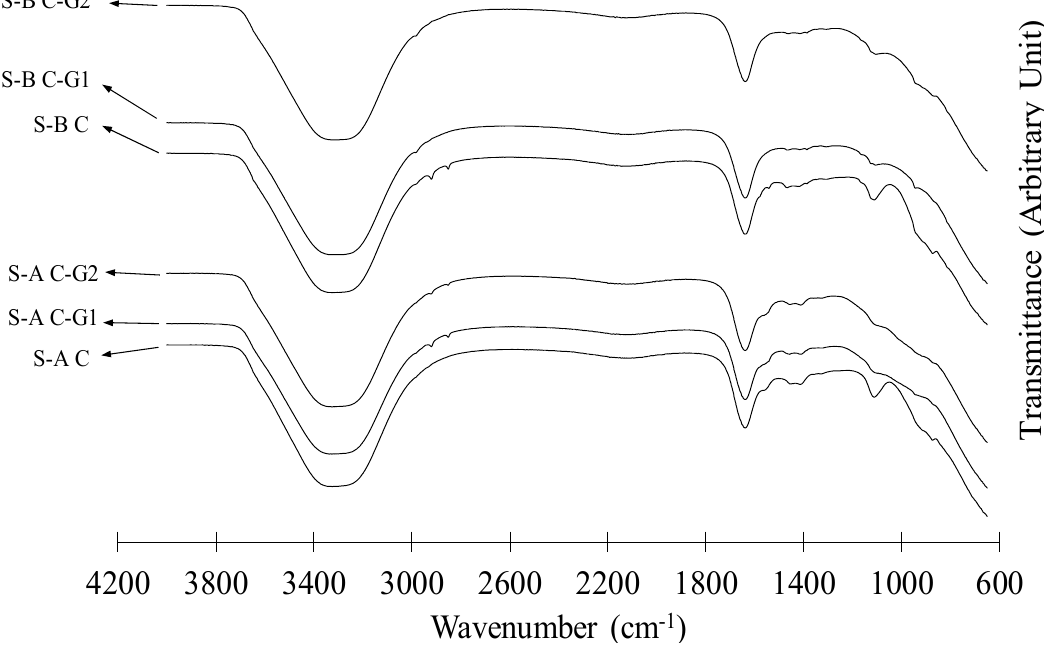
Figure 2. FTIR spectra of S-A and S-B after absorption in different slurries. Table 4. Flow values and percentages of S-A and S-B in different pastes obtained from the flow test. Paste Designation S-A (% per Binder Mass)